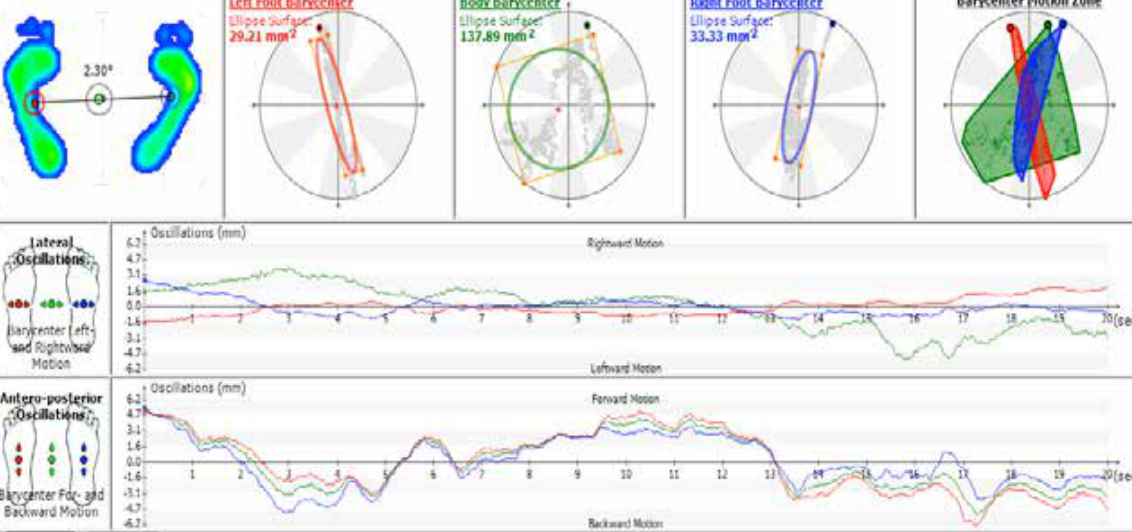
Fig. 3. Sample diagram with the results of the subject’s body balance from the Biomech Studio